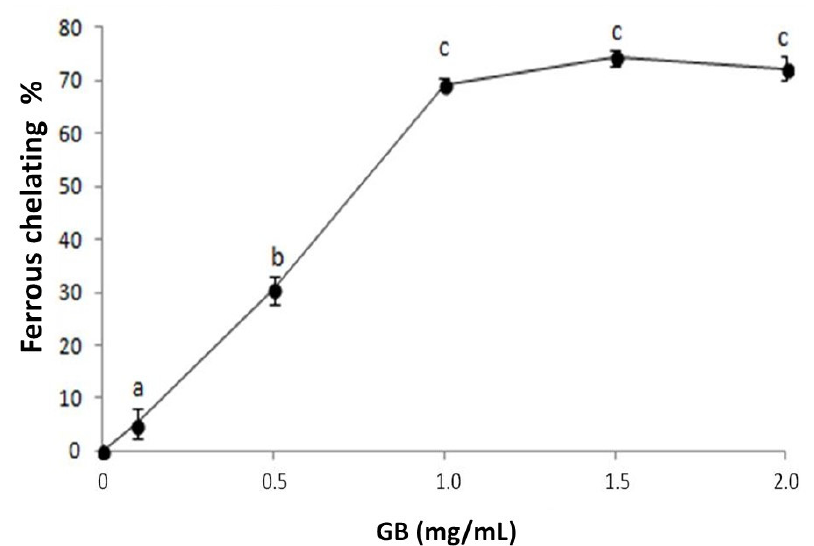
Figure 2. GB chelating effect on ferrous ions. Data are expressed as mean ± standard deviation. The letters “a–c” indicate significant differences between GB concentrations obtained using one-way ANOVA, followed by the Student-Newman-Keuls test ( p < 0.05).